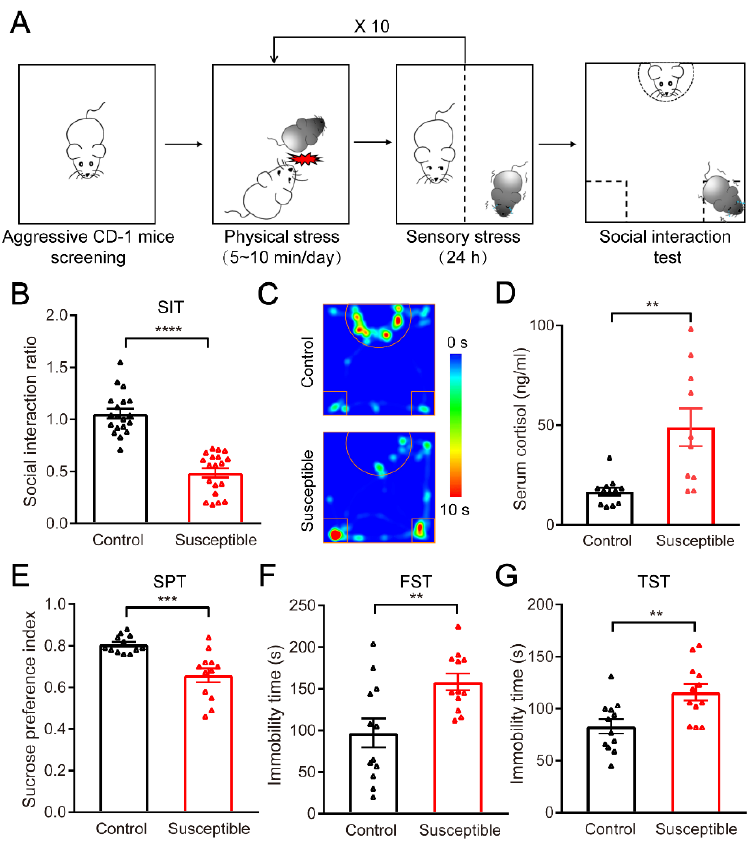
Figure 1. Chronic social defeat stress (CSDS) paradigm and depression-like phenotype in susceptible mice. ( A ) Experimental design of chronic social defeat stress (CSDS) using the resident intruder paradigm. ( B ) The social interaction ratio of susceptible mice compared to non-stressed controls ( n = 19), p < 0.0001. ( C ) Representative trajectory heat maps of social interaction test between non-stressed controls (top) and susceptible mice (bottom). ( D ) The concentration of serum cortisol in non-stressed controls ( n = 10) and susceptible mice ( n = 12), p = 0.016. ( E ) The sucrose water preference test (SPT) in non-stressed controls ( n = 12) and susceptible mice ( n = 12), p = 0.0004. ( F ) The immobility time of the forced swimming test (FST) in non-stressed controls ( n = 12) and susceptible mice ( n = 12), p = 0.0059. ( G ) The immobility time of the tail-suspension test (TST) in non-stressed controls ( n = 12) and susceptible mice ( n = 12), p = 0.005. Unpaired t test. All data represent mean ± SEM. ** p < 0.01, *** p < 0.001, **** p < 0.0001.